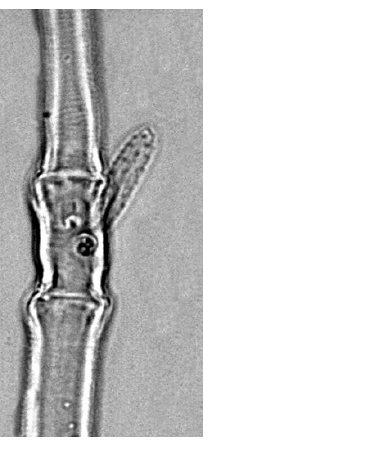
Figure 22. Neophyllobius muscantribii . Female. Genu I. Scale bar: 50 μ m.